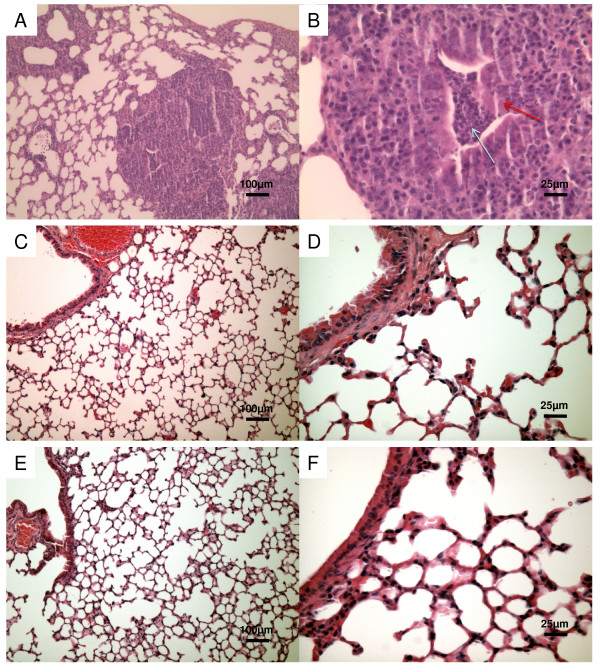
Lung sections of mice vaccinated with OprF-pulsed DCs and infected with clinical isolate. Lung sections A-B representing histologic pictures of pneumonia similar to those described in fig. 4 are shown (red arrow: bronchial epithelium; blue arrow: neutrophilic infiltrate). Lung sections from mice vaccinated with n-OprF-pulsed DCs (C-D) and His-OprF-pulsed DCs (E-F) show a lung in which inflammatory cell recruitment was greatly reduced. Lung sections were hematoxylin-eosin stained. A-C-E magnification ×10. B-D-F magnification ×40.